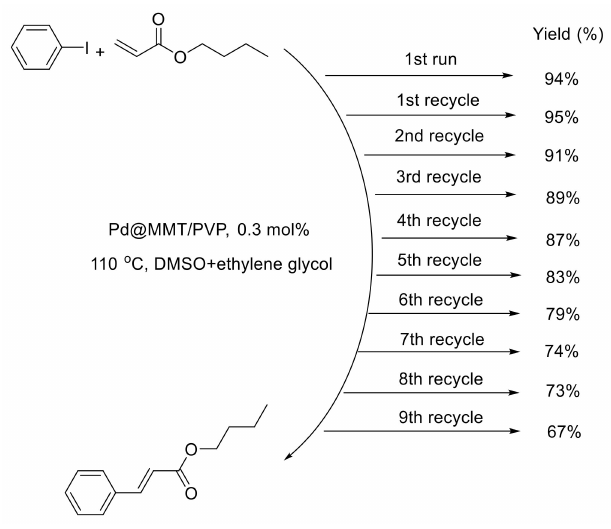
Figure 6. Dependence of the Heck reaction yield on the recycle times of the Pd 0 @MMT/PVP catalytic